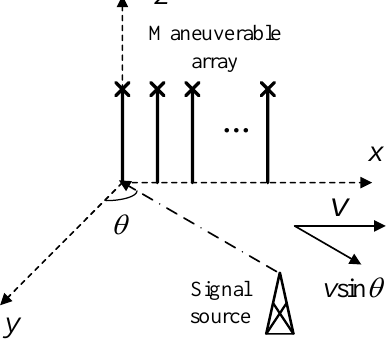
Figure 1. Diagram of moving array.